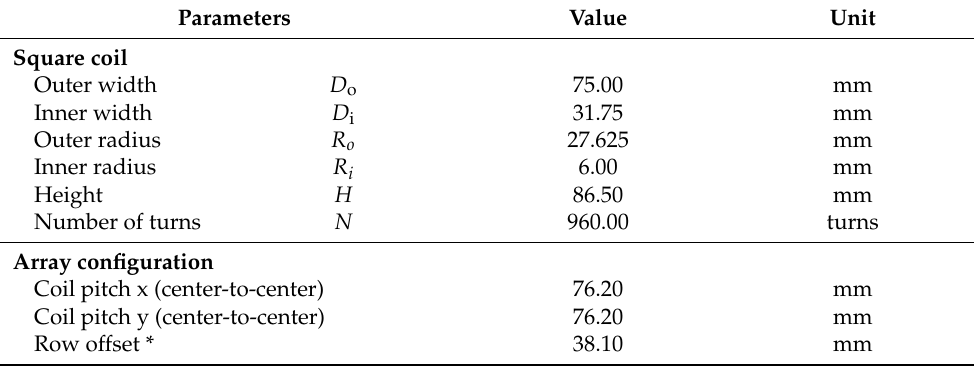
Figure 4. Normalized Fabry factor (red (cid:7) ) and normalized z-component of the force (blue 4-inch diameter × 1/2-inch thickness disc magnet grade N50 with a 20 mm gap above the center of a square coil with different numbers of vertical turns. Table 3. Square coil specifications and coil array configuration